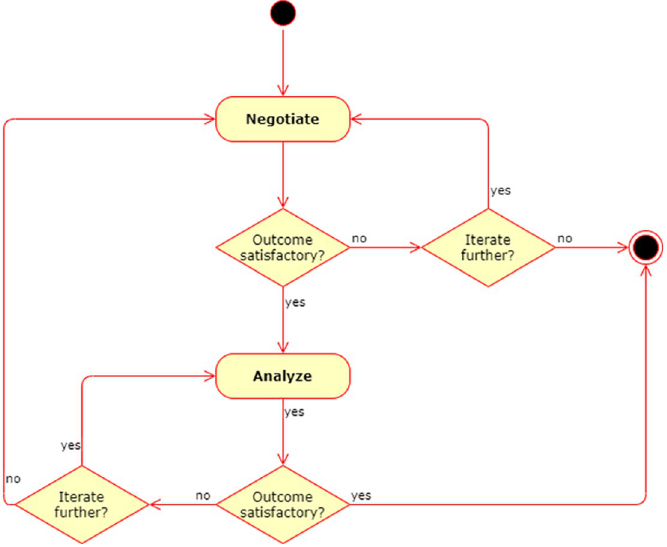
Fig 2. Transitions between cycles. A decision is taken at the end of each execution of a collaboration cycle. This can lead to a repeat of the same cycle, a transition to the other cycle or the conclusion of the